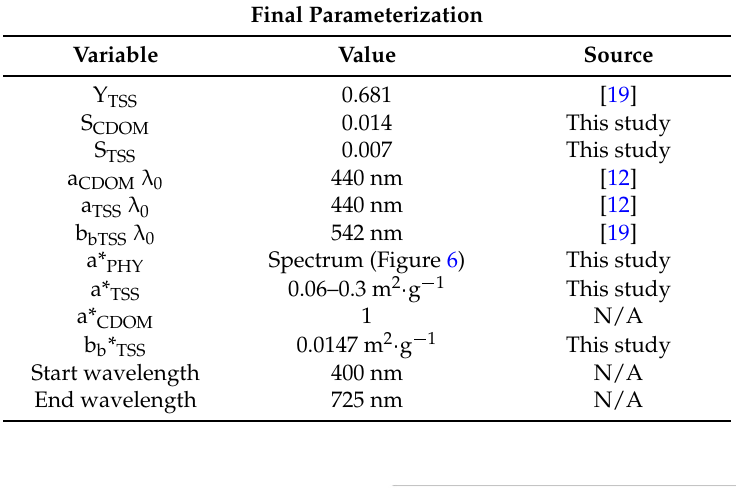
Table 3. Final parameterization of full semi-analytical model.